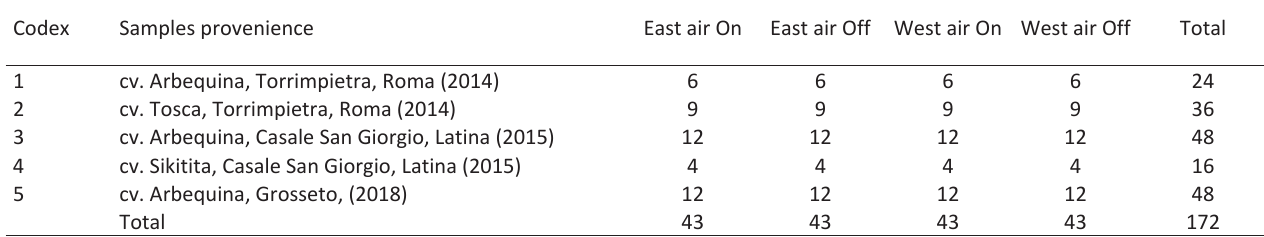
Table 1 - List of the sampling units related to different cultivar and locality